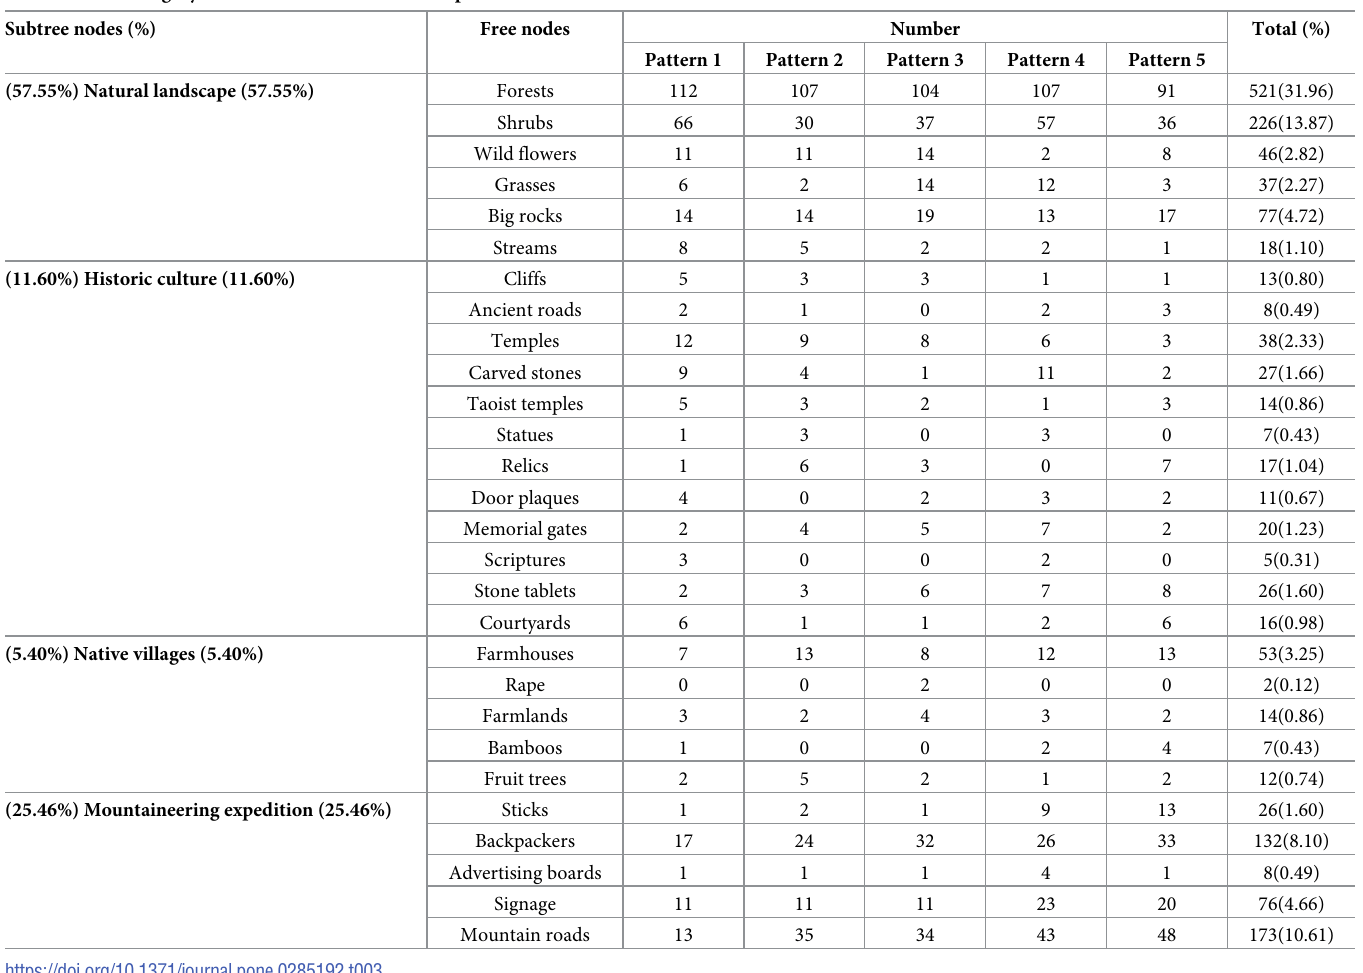
Table 3. Node category and statistics of each behavior pattern. Subtree nodes (%)